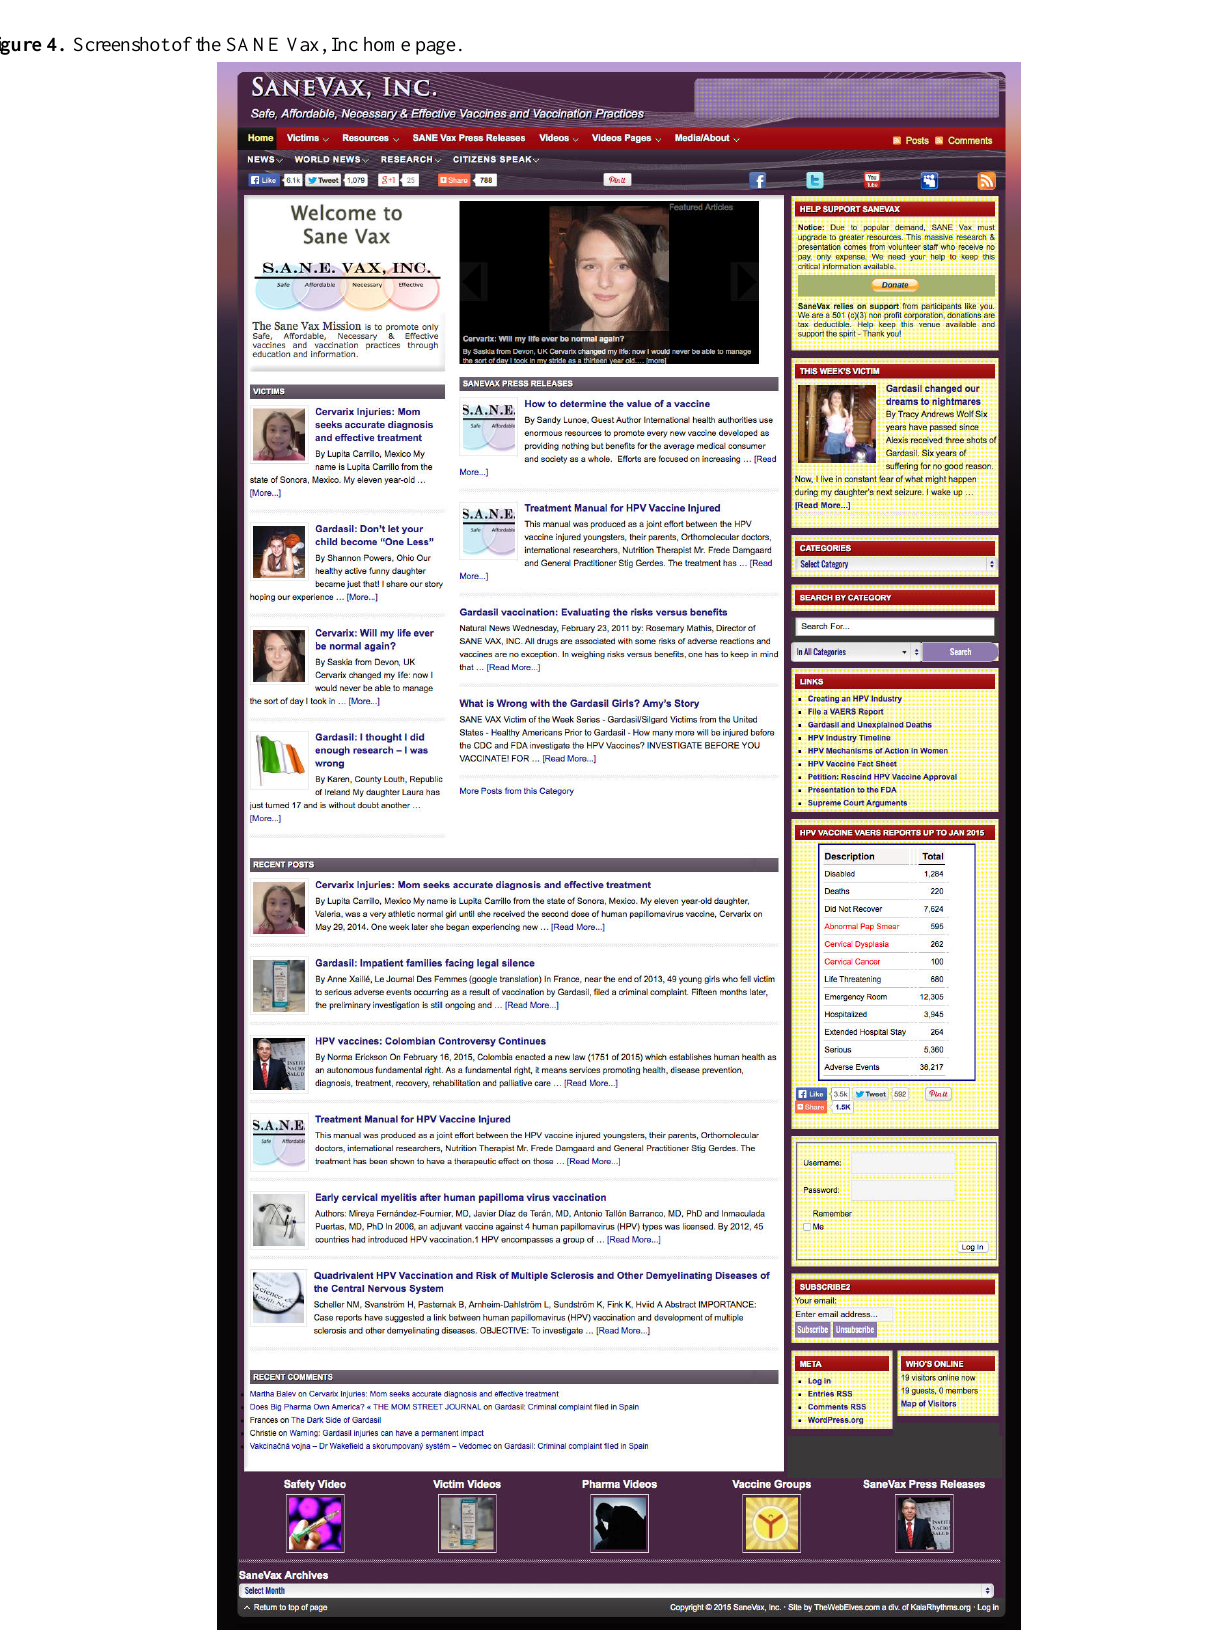
Figure 4. Screenshot of the SANE Vax, Inc home